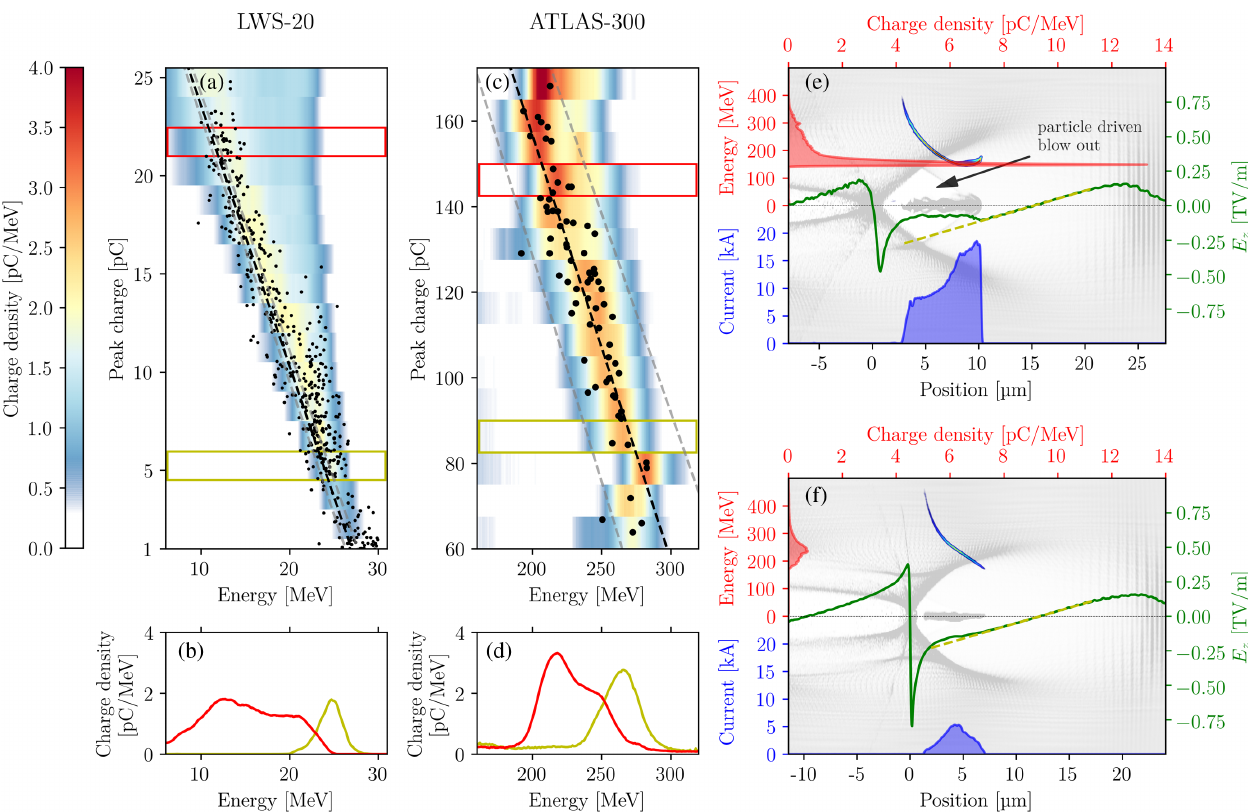
FIG. 3. Beam-loading effects on single laser-accelerated electron bunches. Change of the spectral shape with beam charge. (a) Binned LWS-20 data including the location of the peak energy and peak charge for the individual shots. Lineouts for two bins of high and low charge as marked in their respective colors in (a) are given in (b). (c) shows binned spectra of a dataset acquired using ATLAS-300. Two individual lineouts are given in (d). Dashed black and gray lines indicate linear fits and standard deviations according to Eq. (4) and (3), respectively. (e) and (f) summarize the results of particle-in-cell simulations for the ATLAS-300 parameters for different focus positions, yielding either high beam charge (e) or low beam charge (f). The on-axis field is plotted in green, with dashed yellow lines as the linear fit to the front of the wakefield to show the influence of beam loading. The beam current is plotted as a shaded blue area (bottom), while the spectrum is shown on the left (shaded red). The gray background shows a map of the electron density, while the colored plot shows the electron phase